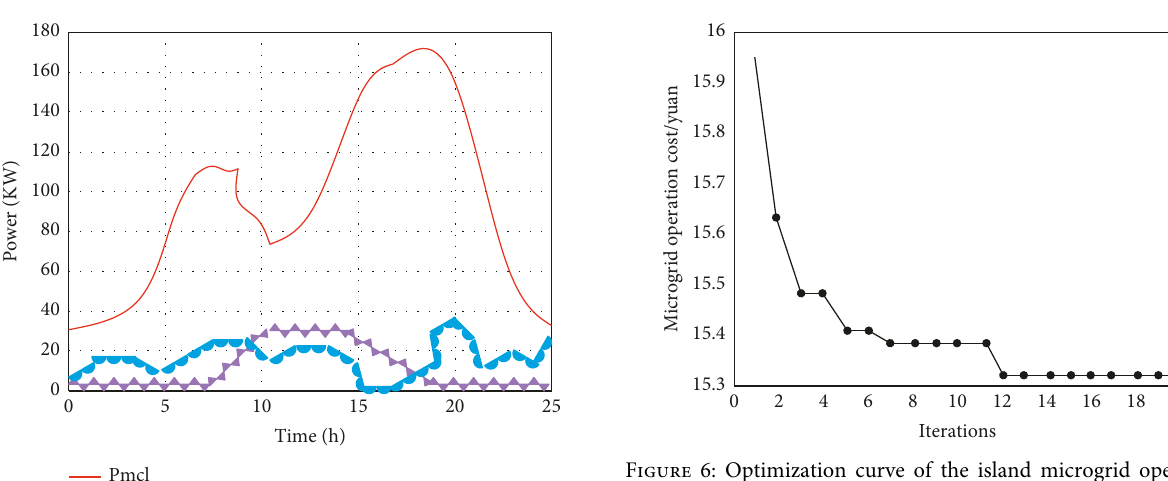
Figure 6: Optimization curve of the island microgrid operating cost in the 20th period.